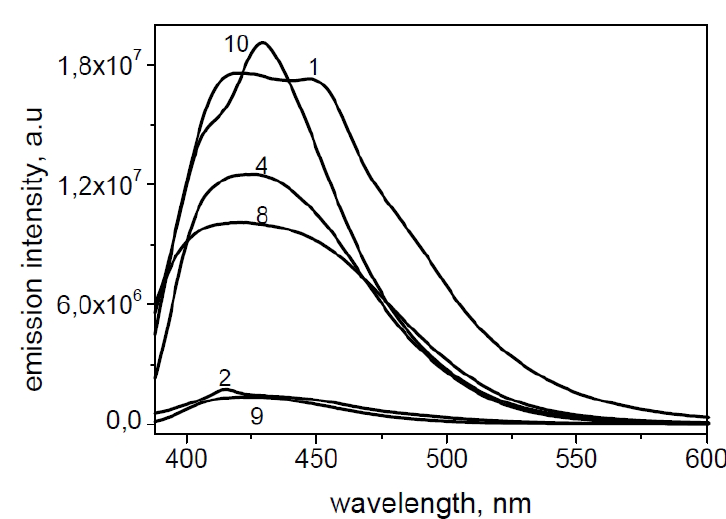
Figure 10. Emission spectra of 1 , 2 , 4 , 8 – 10